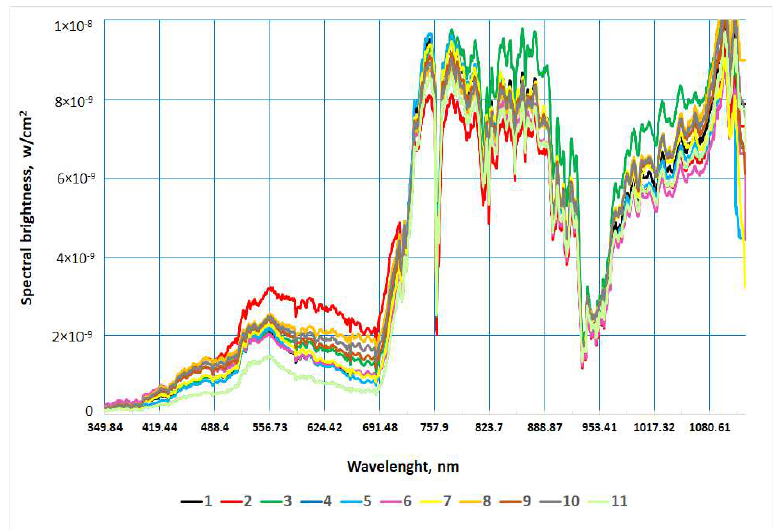
Figure 1. Average graphs of the dependence of spectral brightness on the wavelength of cultivated and weed